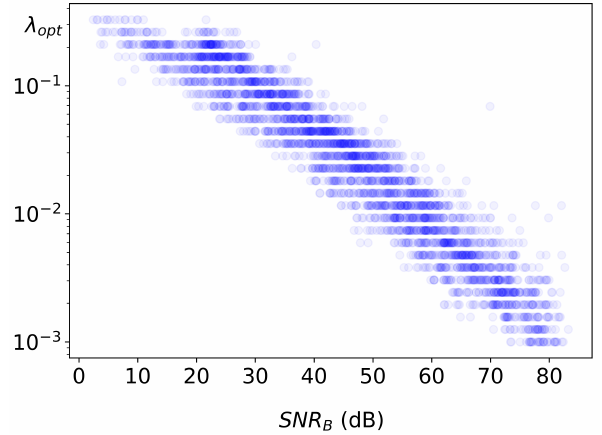
Figure 4. Dependence of λ opt on the input SNR B